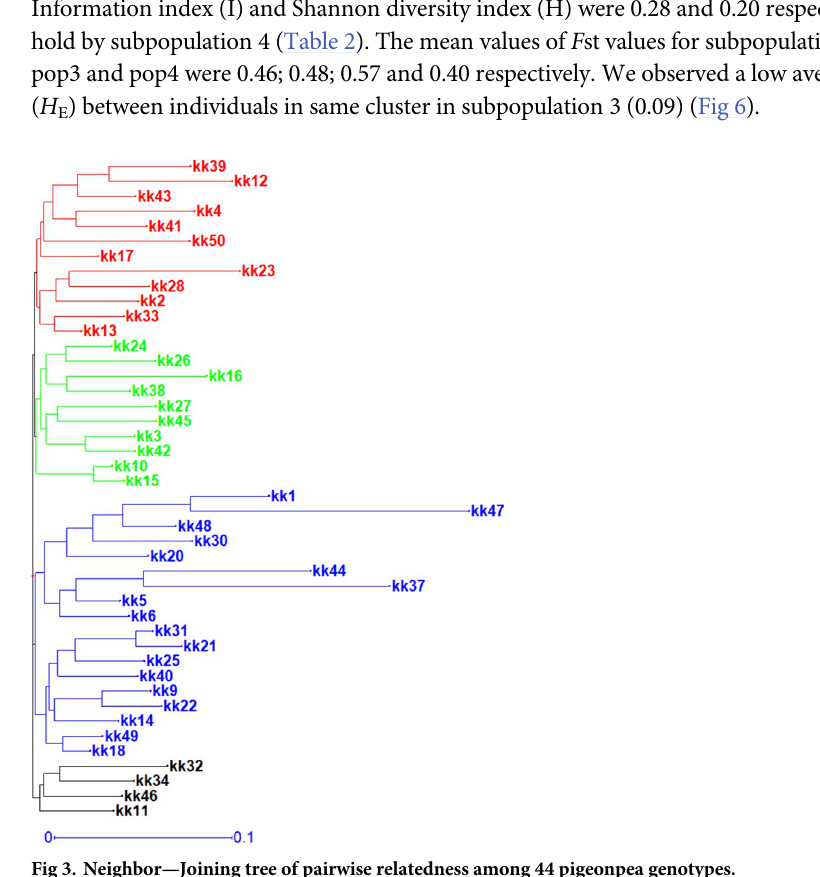
Fig 3. Neighbor—Joining tree of pairwise relatedness among 44 pigeonpea